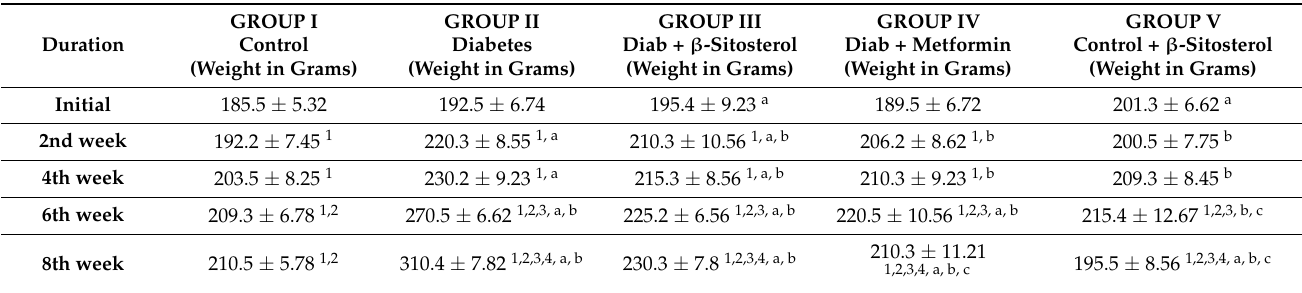
Table 1. Effect of SIT on body weight changes in adult male rats fed with high fat and sucrose-induced for 8weeks. β -sitosterol controlled body weight gain and ameliorated obesity.